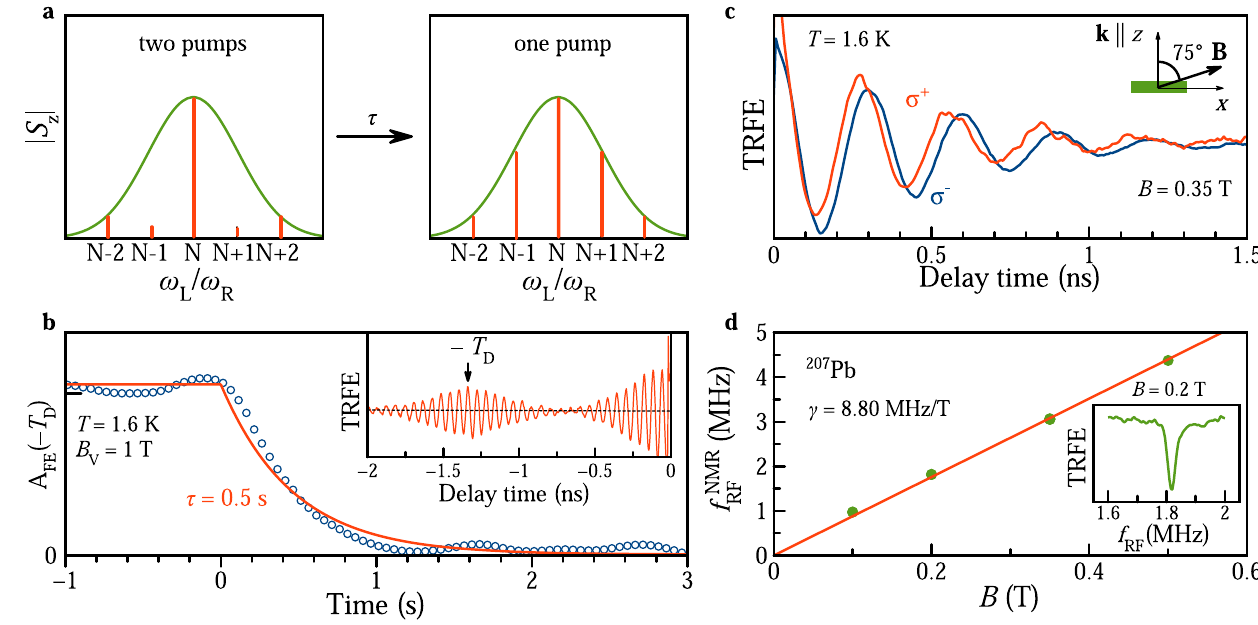
Fig. 2 | Hole-nuclei hyper fi ne interaction. a Schematic representation of the distribution ∣ S z ∣ of spin precession modes within the g -factor spread (green Gaussian) in the two-pump compared to the one-pump protocol. b Relaxation dynamics of the burst amplitude A FE ( − T D ) measured by switching from two-pump toone-pumpprotocol. T =1.6Kand B V =1T.Exponential fi tgivesdecaytimeofthe burst amplitude τ =0.5 s, corresponding to the changeover time between the distributions, after blocking the second pump.Inset showsTRFE fornegativetime